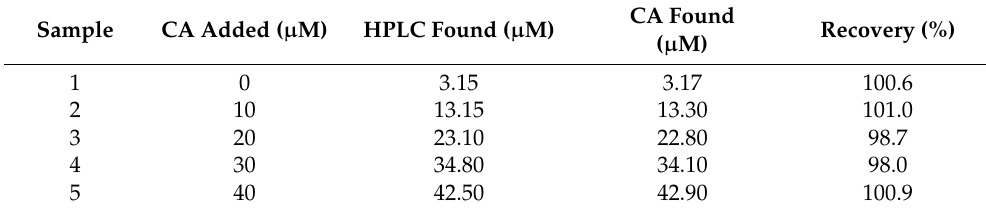
Table 2. Measurement results of caffeic acid in Na 2 HPO 4 –citric-acid